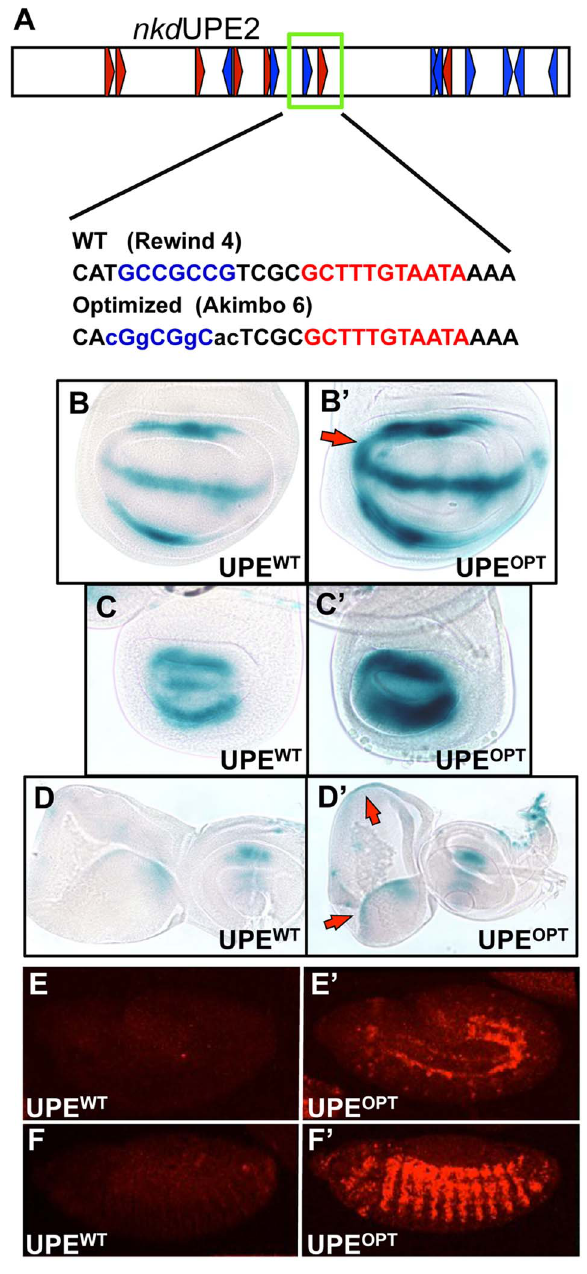
Figure 7. Optimizing motif architecture increases transcrip- tional output. (A) Cartoon of the nkd UPE2 W-CRM. A RW4 motif (green box) was altered to an AK6, point mutations indicated in lowercase. (B–D) Brightfield images of 3 rd instar imaginal discs stained with X-gal. The ‘‘optimized’’ AK6 containing (OPT) W-CRM (B 9 , C 9 , D 9 ) drives higher expression levels of the reporter transgene than the wildtype (WT) W-CRM (B,C,D), and expands the region which responds to Wg signaling (red arrows). Representative wing (B), haltere (C), and eye/antennal (D) imaginal discs shown. (E,F) Confocal images of lacZ immunostained nkd UPE2 W-CRM reporters at embryonic stage 12 (E, E 9 ) and stage 13 (F, F 9 ). The ‘‘optimized’’ reporter has a dramatic increase in (Figure 8, 9B 9 ). In addition, these embryos secreted cuticle with the standard patterning defects seen with reduced Wg signaling [63,71], but no cuticle defects associated with loss of cellular